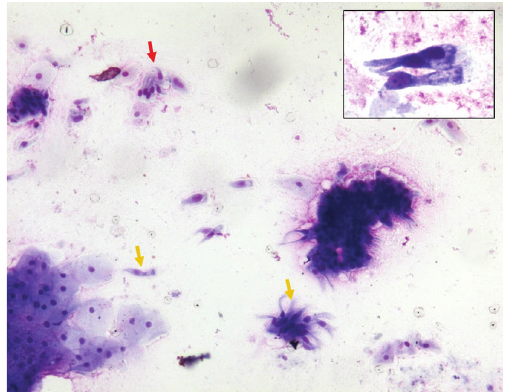
Figure 2: Cytological smears showed, in a mucoid background, scattered histiocytes, gastric and oesophageal mucosal cells, and few groups of ciliated columnar cells (MGG, 200x; inset